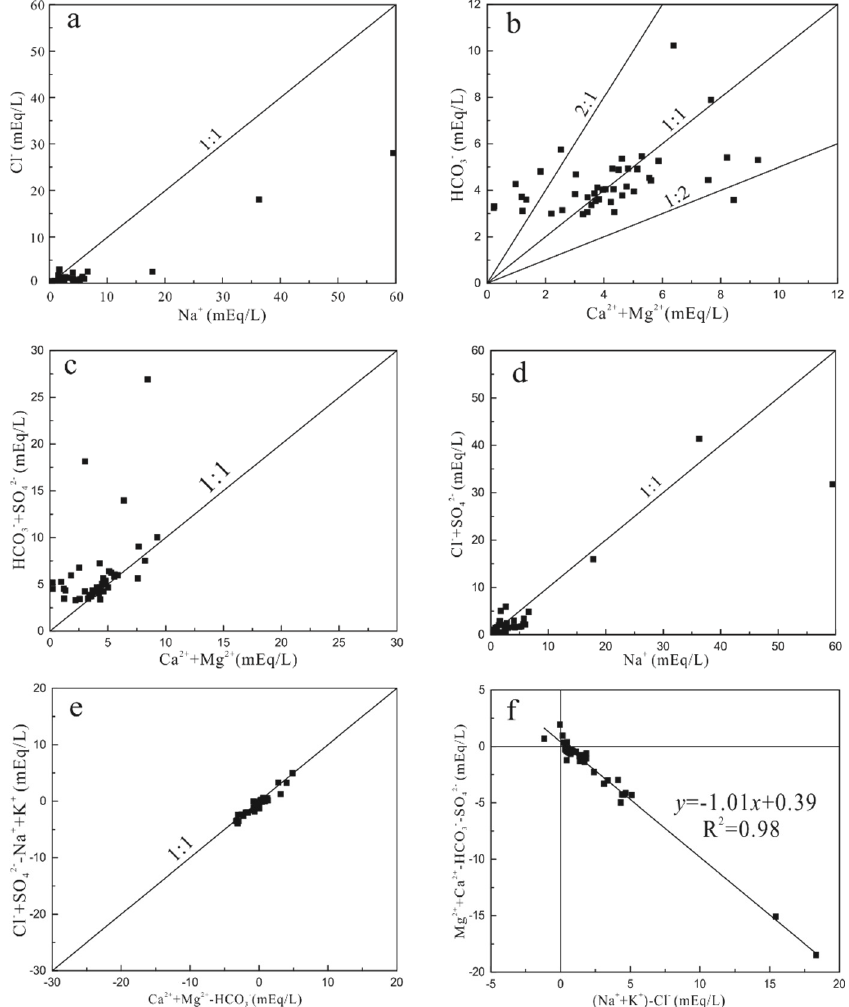
Figure 3. Relationships between different ions with solid lines representing the theoretical dissolution curves (( a ). Na + vs. Cl − ( b ). Ca 2+ + Mg 2+ vs. HCO 3 − ( c ). Ca 2+ + Mg 2+ vs. HCO 3 − + SO 42 − ( d ). Na + vs. Cl − + SO 42 − ( e ). Ca 2+ + Mg 2+ -HCO 3 − vs. Cl − + SO 42 − -Na + + K + ( f ). (Na + + K + )-Cl − vs. Ca 2+ + Mg 2+ -HCO 3 − -SO 42 − ) .